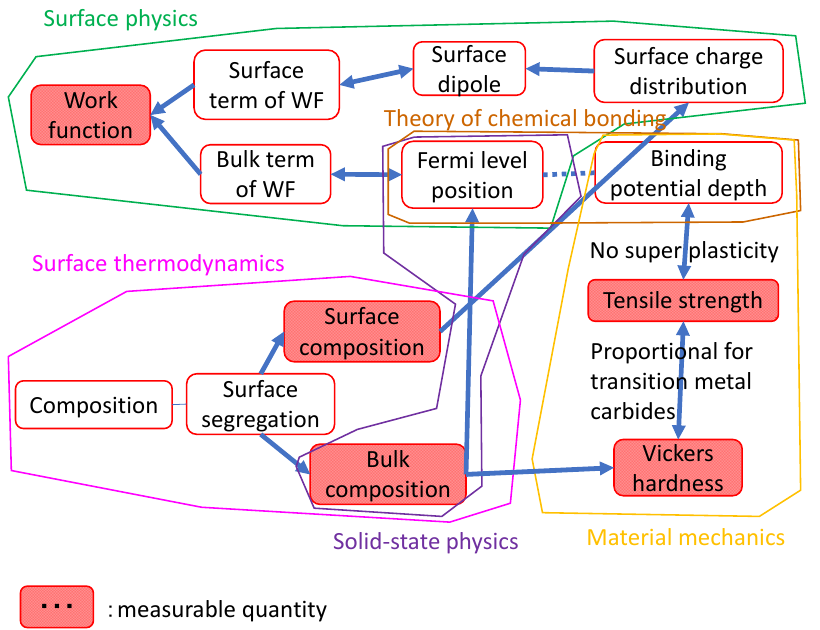
Figure 6. Relationships among factors that contributing to the work function, compiled from descriptions in books and review articles.